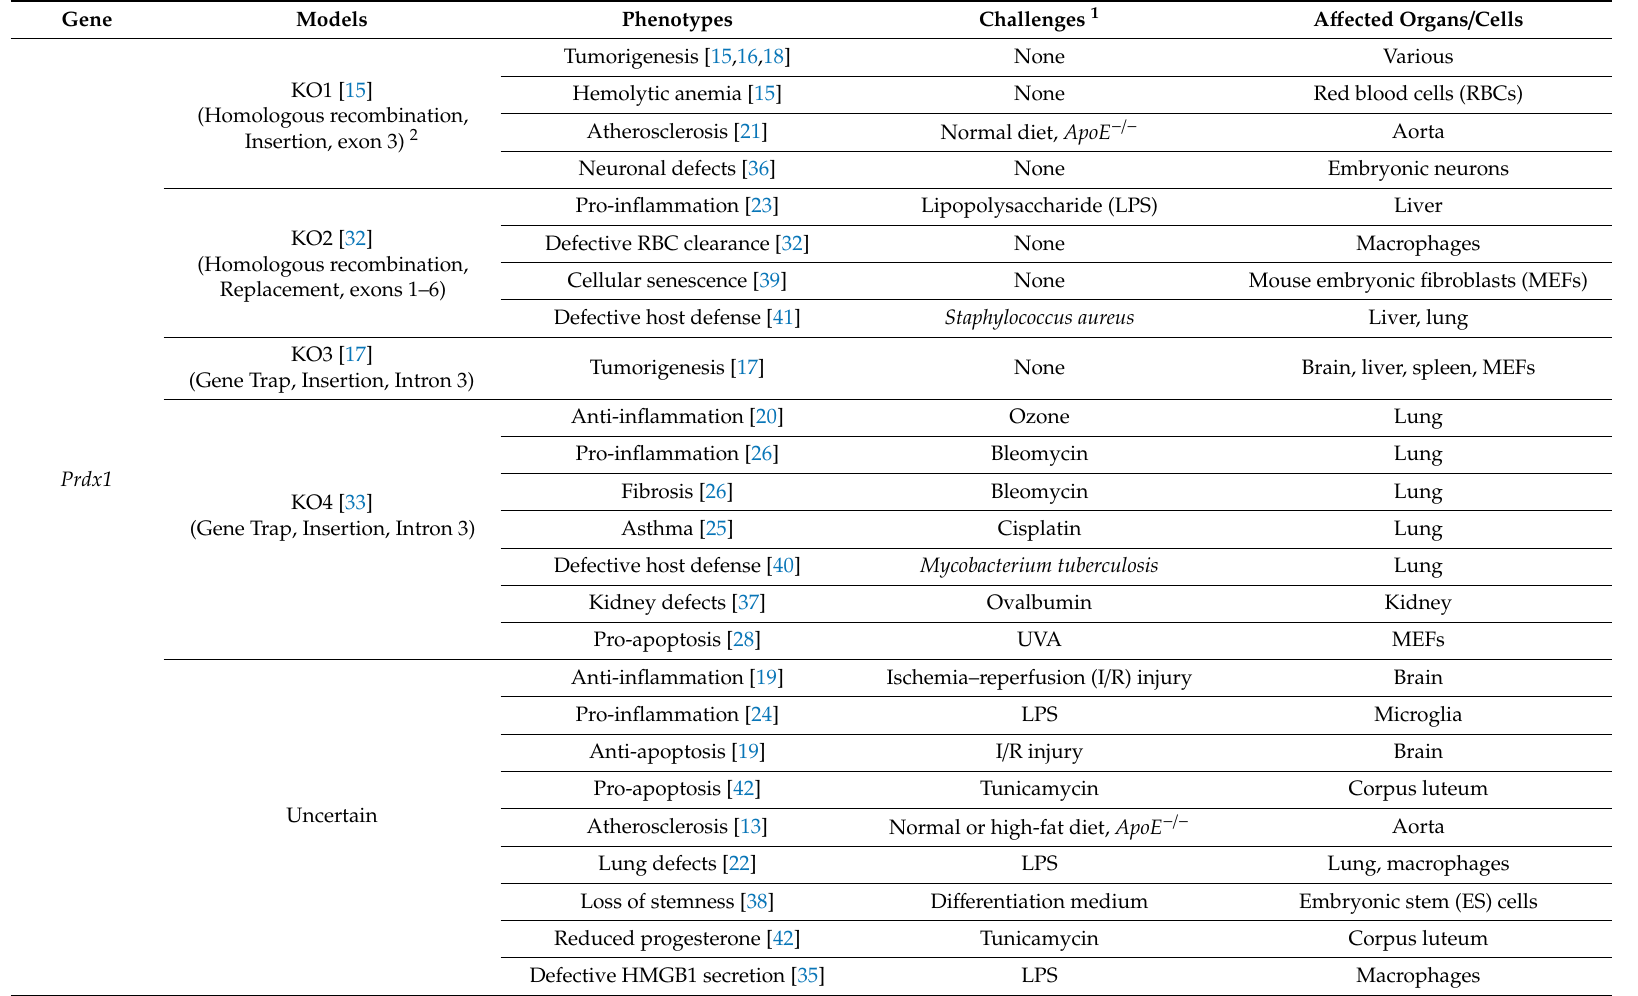
Table 1. Knockout mouse models of